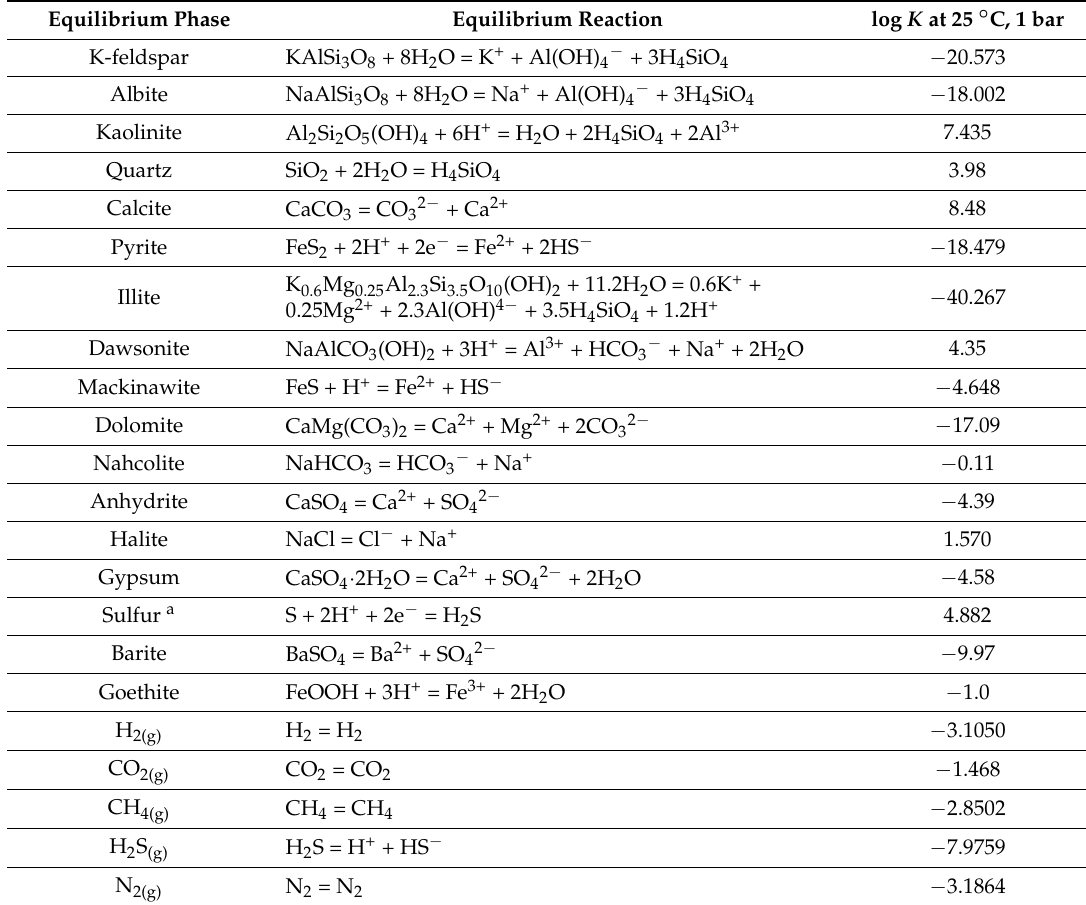
Table 1. Equilibrium phases, mass action equations, and equilibrium constants used in the model. Data from phreeqc.dat, except for dawsonite, nahcolite, CH 4(g) , H 2 S (g) , N 2(g) , which are from llnl.dat